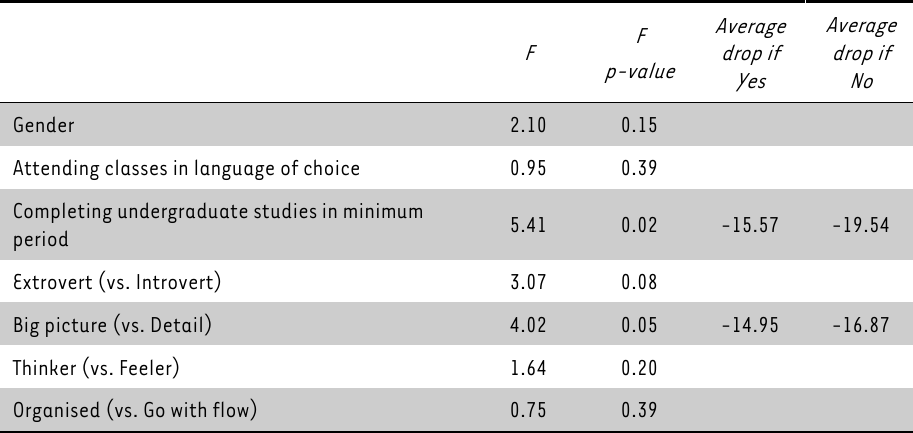
TABLE 5: Influence on drop in marks Gender